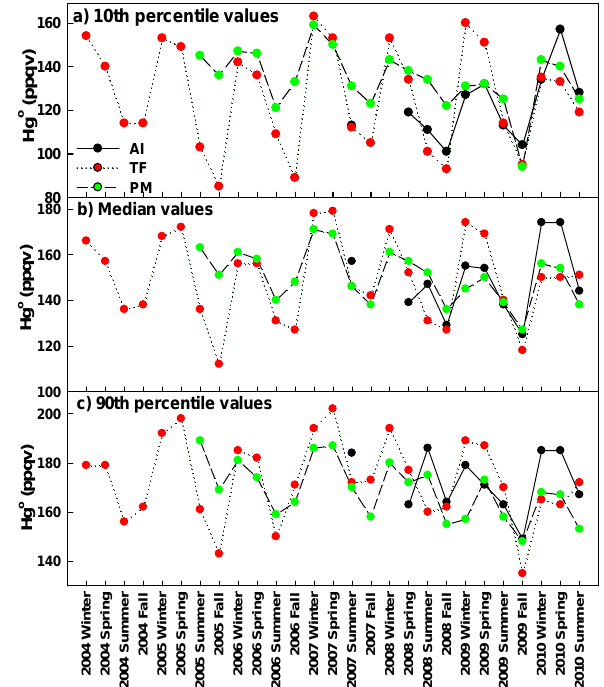
Fig. 3. Seasonal 10th percentile (a) , median (b) , and 90th percentile Figure 3. Seasonal 10 th percentile (a), median (b), and 90 th percentile (c) (c) mixing ratios of Hg 0 at AI (black), TF (red), and PM (green). mixing ratios of Hg  at AI (black), TF (red), and PM (green). locities of Hg 0 are two to four orders of magnitude smaller than for other surface types (Zhang et al., 2009, and refer- ences therein). The slower rate of increase at PM may reflect its relatively remote location and higher altitude where an- thropogenic influence is dampened compared to AI and TF that are closer to source